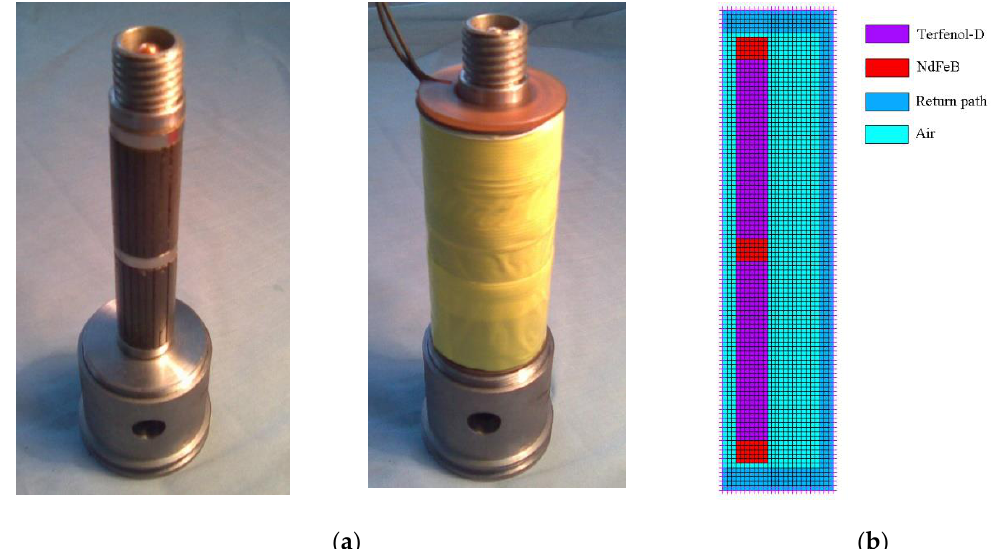
Figure 2. Stacked core of the Terfenol-D transducer and the finite element model of the magnetic circuit. ( a ) The segmented stack; ( b ) the finite element model.